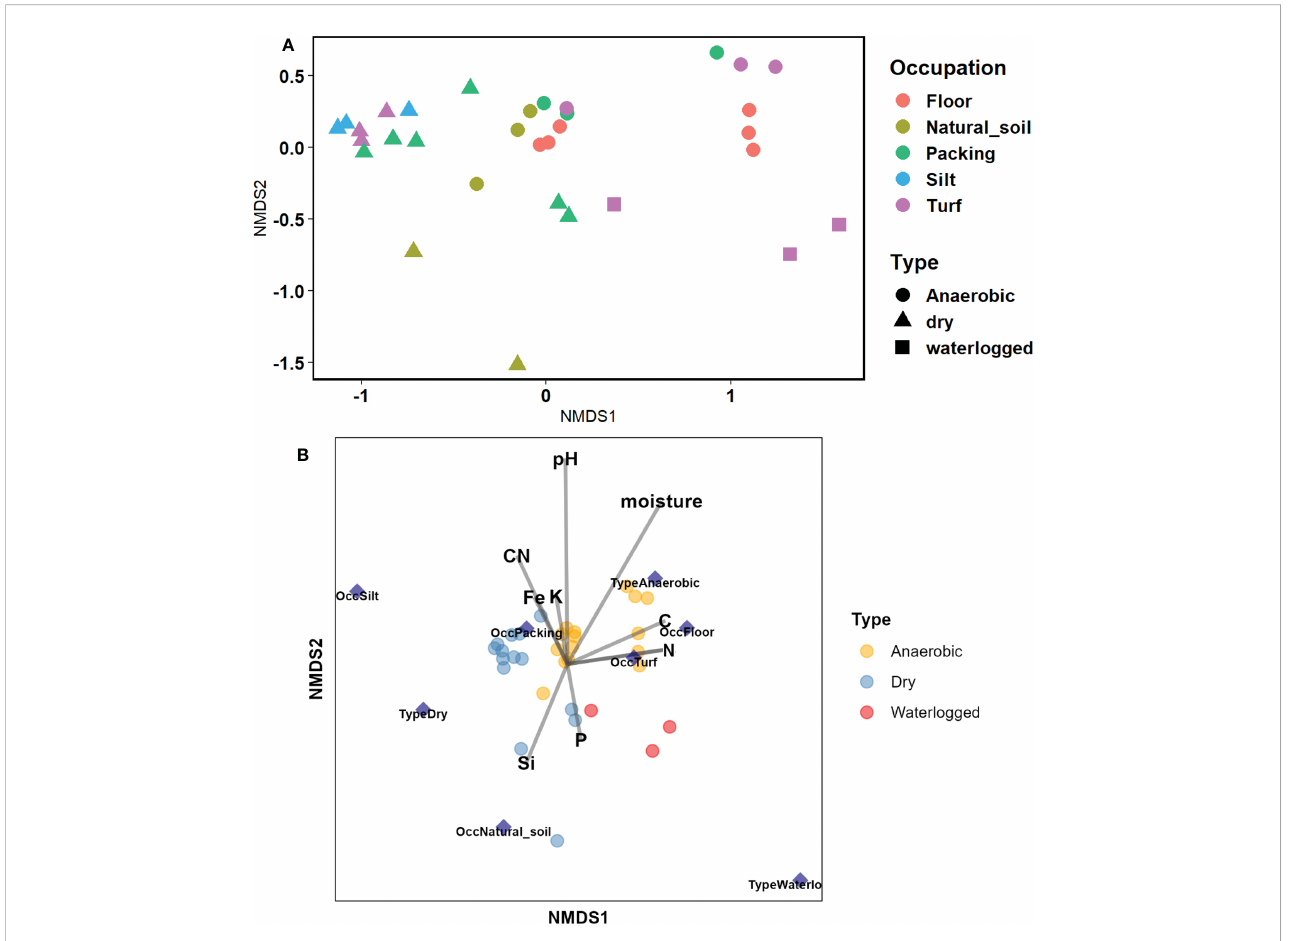
FIGURE 5 (A) NMDS using Bray distance matrices. Shape of points represents soil type and color of points represents occupation layer. (B) NMDS using Bray distance matrices with environmental variables overlayed. Points are colored based on soil types. Centroid shows center point for Occupation of soils (Occ) and soil type. Stress value =